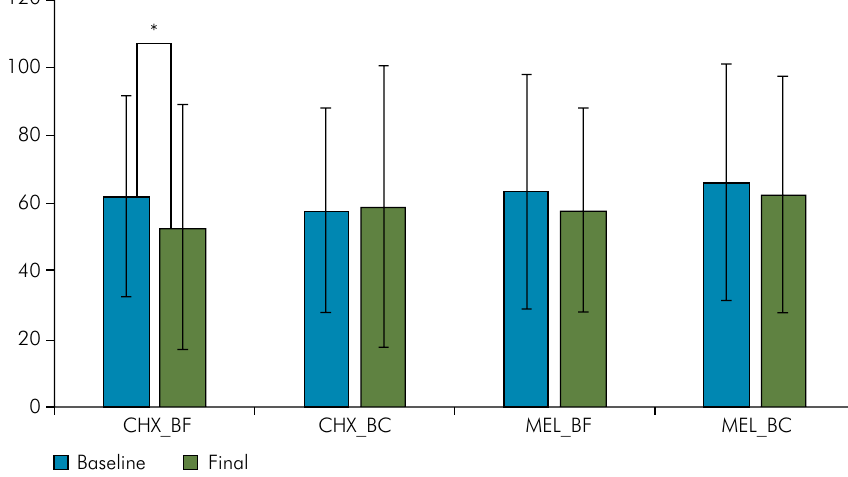
Figure 2. Intergroup comparisons revealed no significant difference (p >